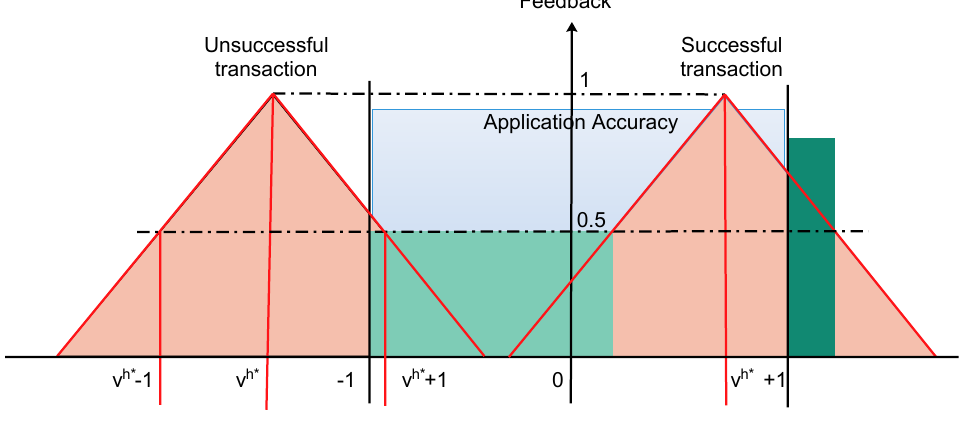
Figure 2. Feedback